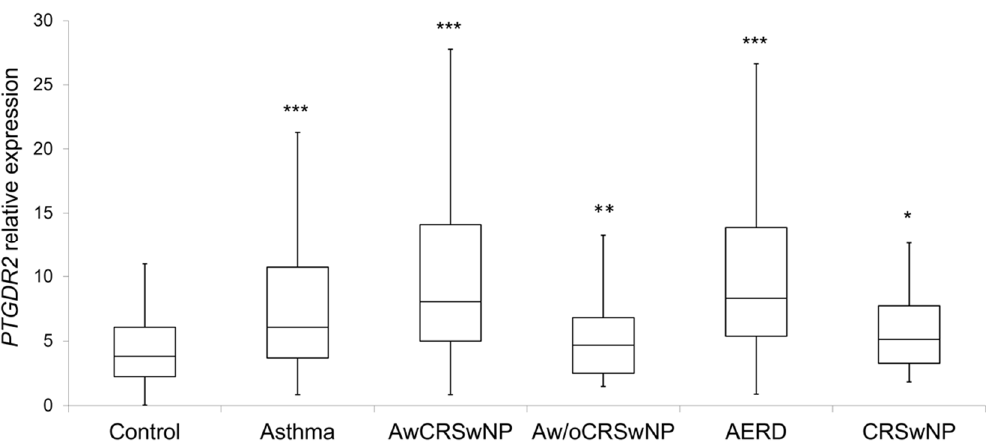
Figure 2. Boxplot of the PTGDR2 expression levels in controls and patients; CRSwNP: Chronic Rhinosinusitis with Nasal Polyposis; AwCRSwNP: Asthma with CRSwNP; Aw/oCRSwNP; Asthma without CRSwNP; AERD: Aspirin-exacerbated respiratory disease; *** p < 0.001; ** p < 0.01; * p < 0.05; p -value of the Kruskal–Wallis test for each group of patient vs. controls after age and sex adjustment. Table 6. Peripheral blood eosinophil, FeNO, and PTGDR2 expression levels according to asthma severity.